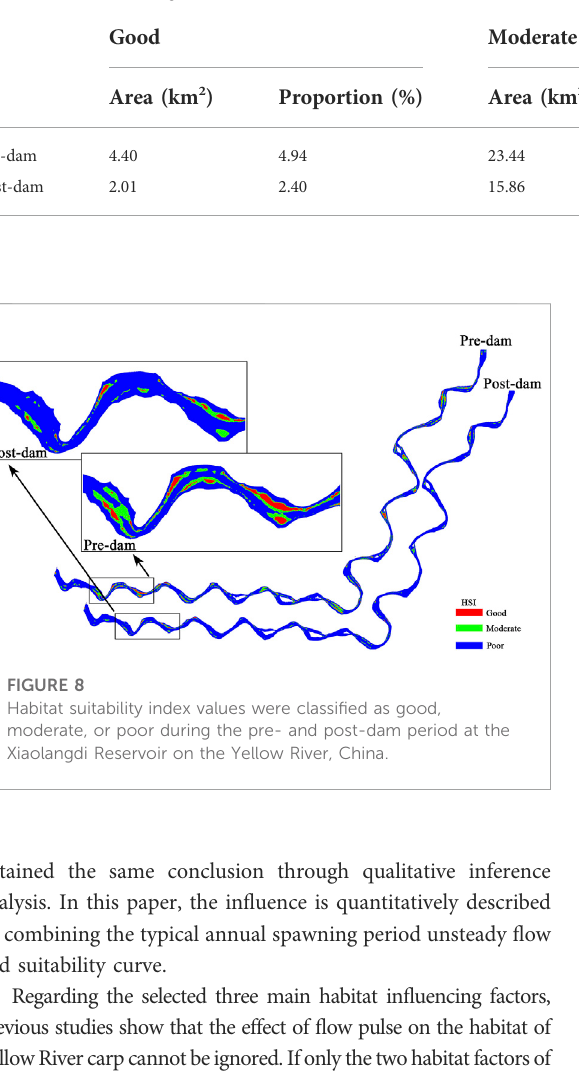
TABLE5Habitatmodelresults:areaandproportionoftotalareaduringthepre-andpost-damperiodattheXiaolangdiReservoirontheYellowRiver, China. Habitat suitability index values were classi fi ed as follows: 0 – 0.3 was poor, 0.3 – 0.5 was moderate, and 0.5 – 1 was good.